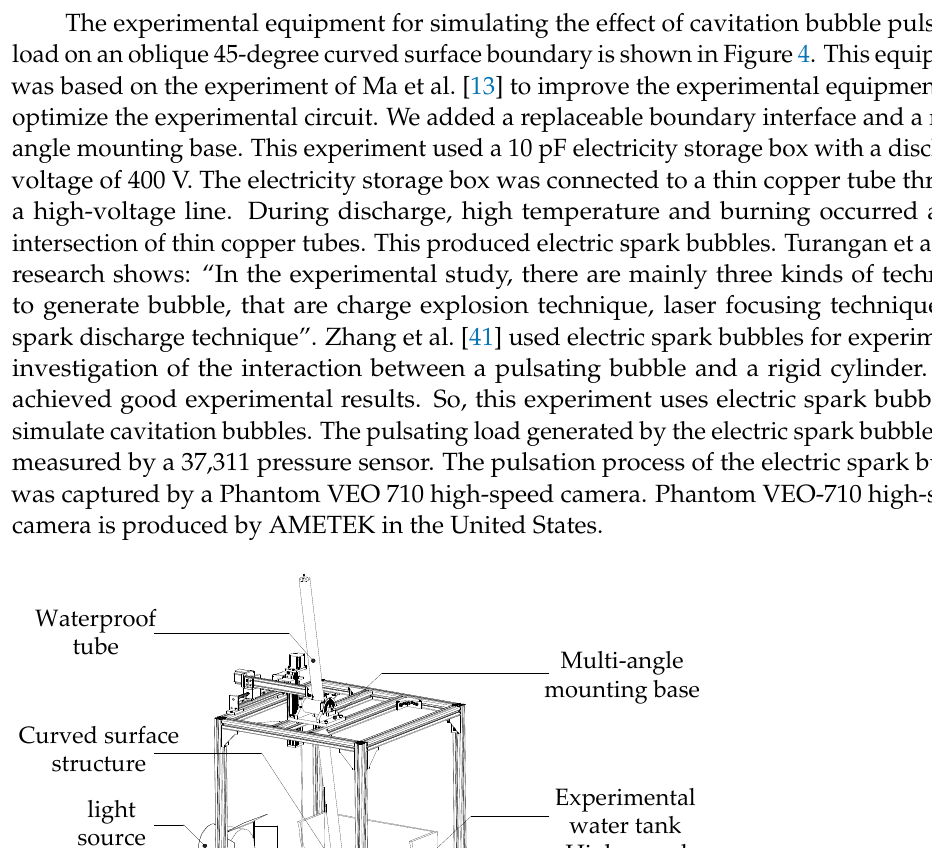
Figure 3. Hemispherical structure with pressure sensor.